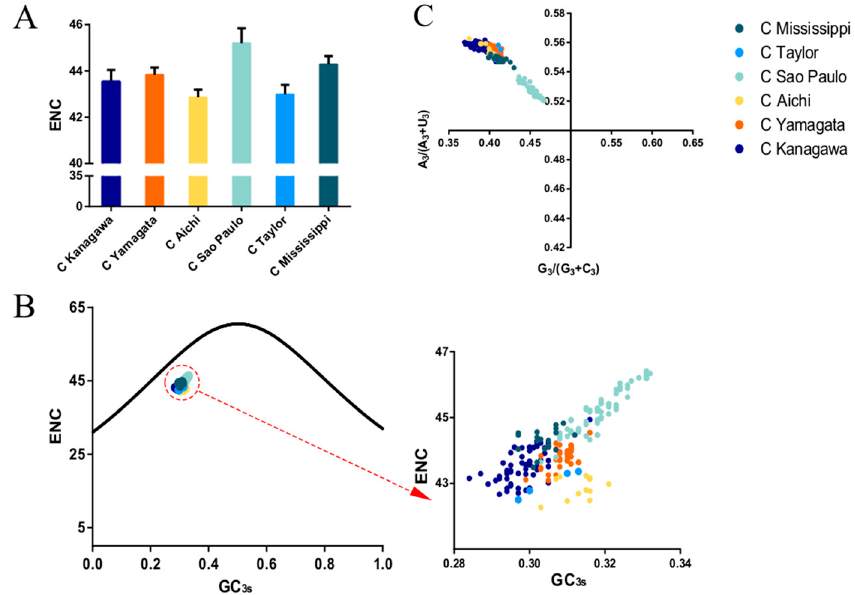
Figure 2. ( A ). The mean and standard deviation of effective number of codons (ENC). The respective evolutionary lineages: C/Kanagawa, C/Yamagata, C/Aichi, C/Sao Paulo, C/Taylor lineage, and C/Mississippi are represented in dark blue, orange, light green, yellow, light blue, and cyan, respectively. ( B ) ENC-plot analysis of the ICV HE gene. The curve represents the standard expected values. The different colour circles represent the observed ENC-GC 3s values of the individual lineages (colours same as A). ( C ) PR2 bias plot of the HE gene.